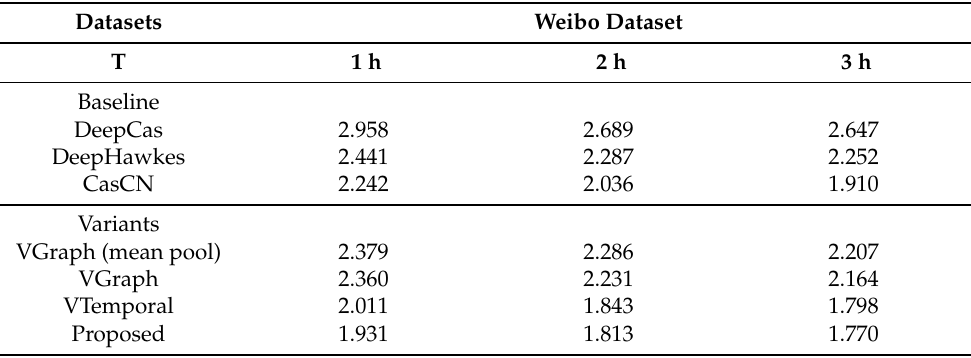
Table 3. Performance comparison of baselines and model